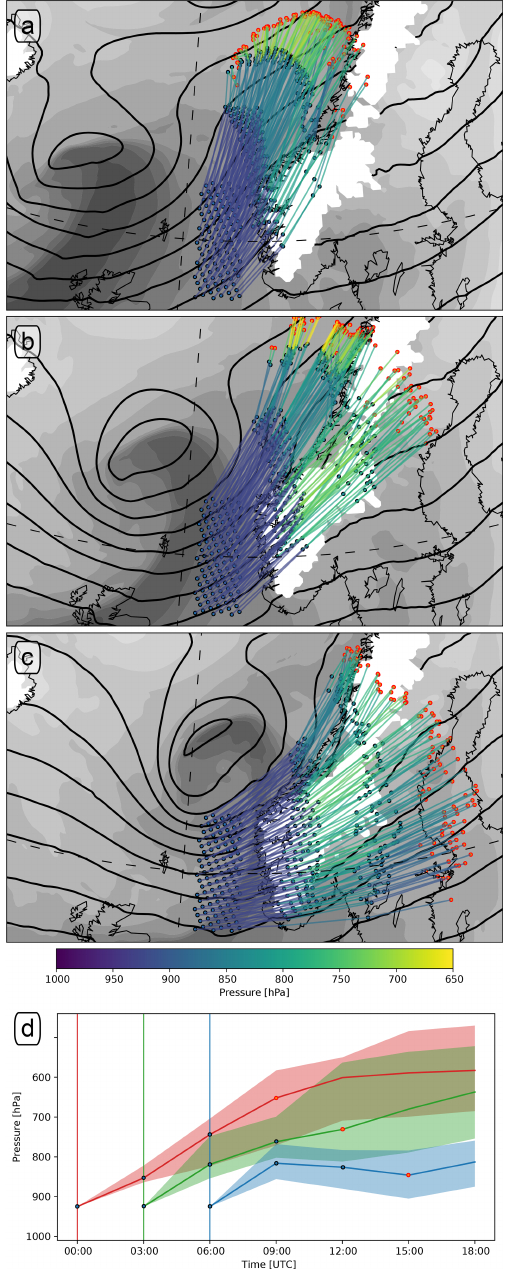
Figure 12. Forward trajectories released from the box 58.0– 62.0 ◦ N, 1.0–4.0 ◦ E at 925hPa at (a) 00:00UTC, (b) 03:00UTC, and (c) 06:00UTC. The trajectory segments between the circles each cover 3h, and they are coloured by pressure (hPa) of the pre- ceding time step. The position of the parcels 9h after the respective release are red. The grey shading and black contours show θ e and geopotential, both at 925hPa, at the release time of the trajectories with the same contour interval and limits as in Fig. 2. Panel (d) shows the median pressure evolution of the above parcels. Circles indicate time steps shown in the trajectory maps (a) – (c) . The re- spective transparent shading indicates variability between the tra- jectories by the 15th and 85th percentiles. The trajectories have been calculated using LAGRANTO (Sprenger and Wernli,